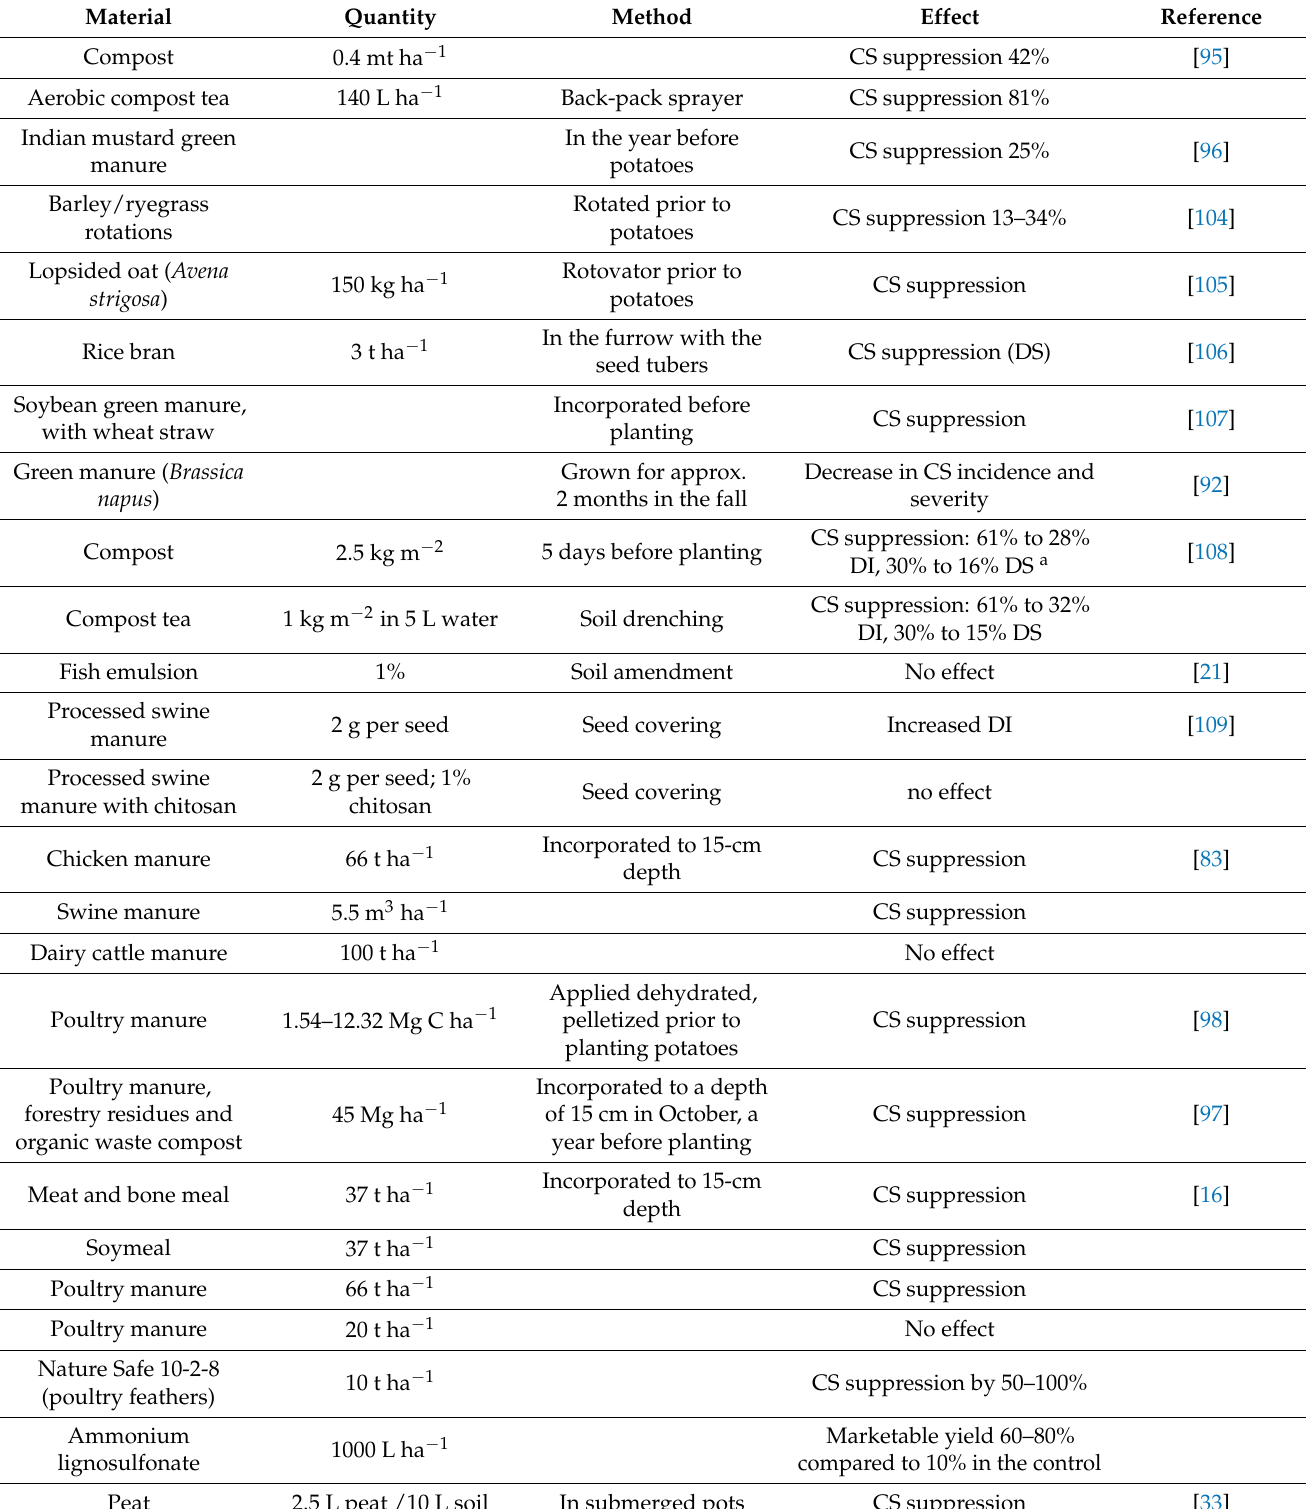
Table 2. Effects of organic matter amendments on incidence and severity of potato common